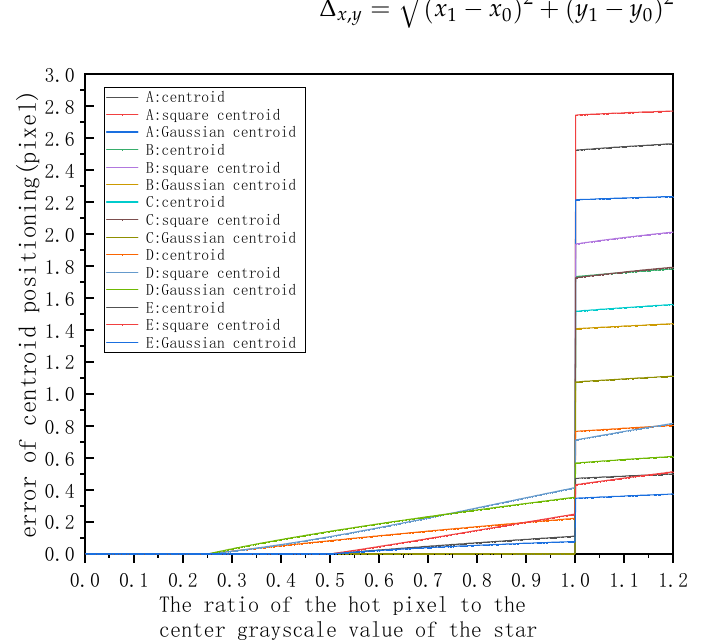
Figure 7. The error of centroid positioning calculated by using different centroid positioning methods. It can be seen from Figure 7 that in the case of D and E, the error of centroid positioning increased with the increase in the grayscale value of the hot pixel. After the grayscale value of the hot pixel exceeded the grayscale value of the center of the star, the error of centroid positioning increased sharply due to the movement of the centroid positioning window, but in these cases, the centroid error calculated by the centroid positioning algorithm was within one pixel. In the case of A, B, and C, since the change of the grayscale value of the hot pixel did not affect the grayscale distribution of the star in the original window, only after the gray-scale value exceeds the grayscale value of the center of the star will the centroid positioning window move, and the error of centroid positioning occur. In these cases, the error of centroid positioning of the star was larger than one pixel, and the maximum error of centroid positioning calculated by the square centroid method exceeded 2.7 pixels. In all cases, the higher the grayscale value of the hot pixel and the farther the distance from the center of the star, the larger the error of centroid positioning; under the same influence conditions, the error of centroid positioning calculated by the